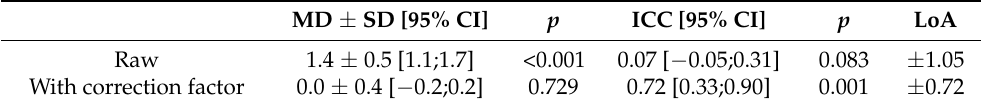
Figure 3. Bland-Altman plots of the mean temperature versus the mean temperature difference. The ( A ) Cosinuss ◦ ◦ Temp, and ( B ) infrared (IR) thermometer compared to mercury thermometer with mean (black), upper and lower limit of agreement (LoA) (black dotted line) and zero-line (blue).